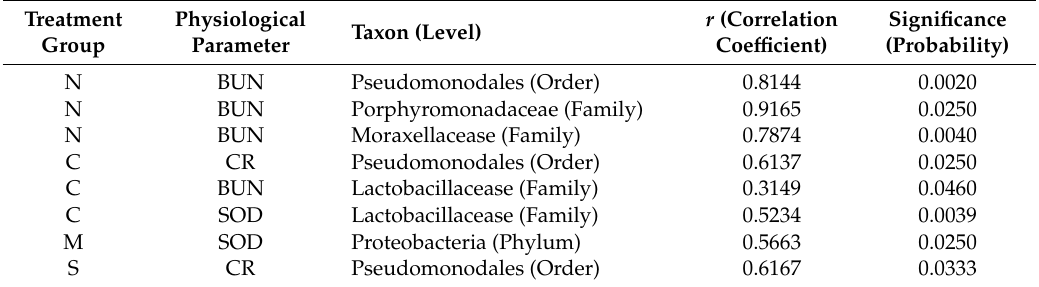
Figure 6. The modules displaying a strong correlation with kidney superoxide dismutase activities (SOD). The interactions among di ff erent nodes (OTUs) within a module were shown: solid line: positive correlation; dashed line: negative correlation. The color of each node (OTU) indicated the phylum this OTU was assigned. The modules C07 and C10, identified from the group C (healthy mice supplemented with a daily dose of 150 mg / kg bodyweight of chondroitin sulfate disaccharide for 16 consecutive days); showed a positive (C07) and negative (C10) correlation with SOD ( p < 0.05), respectively. Similarly, Modules M01 and M14 displayed a positive (M01) and negative (M14) correlation with SOD in the group M, i.e., mice subjected to exhaustive exercise stress supplemented with PBS. The detailed annotation of each OTU node can be found in Table S3. Table 2. The partial Mantel test revealed the correlation between node connectivity of some taxa and the OTU significance of physiological traits in microbial co-occurrence networks. N: healthy mice supplemented with PBS; C: healthy mice supplemented with a daily dose of 150 mg / kg bodyweight of chondroitin sulfate disaccharide (CSD) for 16 consecutive days; M: mice subjected to exhaustive exercise stress supplemented with PBS; S: the stressed mice supplemented with a daily dose of 150 mg / kg bodyweight of CSD for 16 days. BUN: Blood urea nitrogen; CR: creatinine ratio; SOD: superoxide